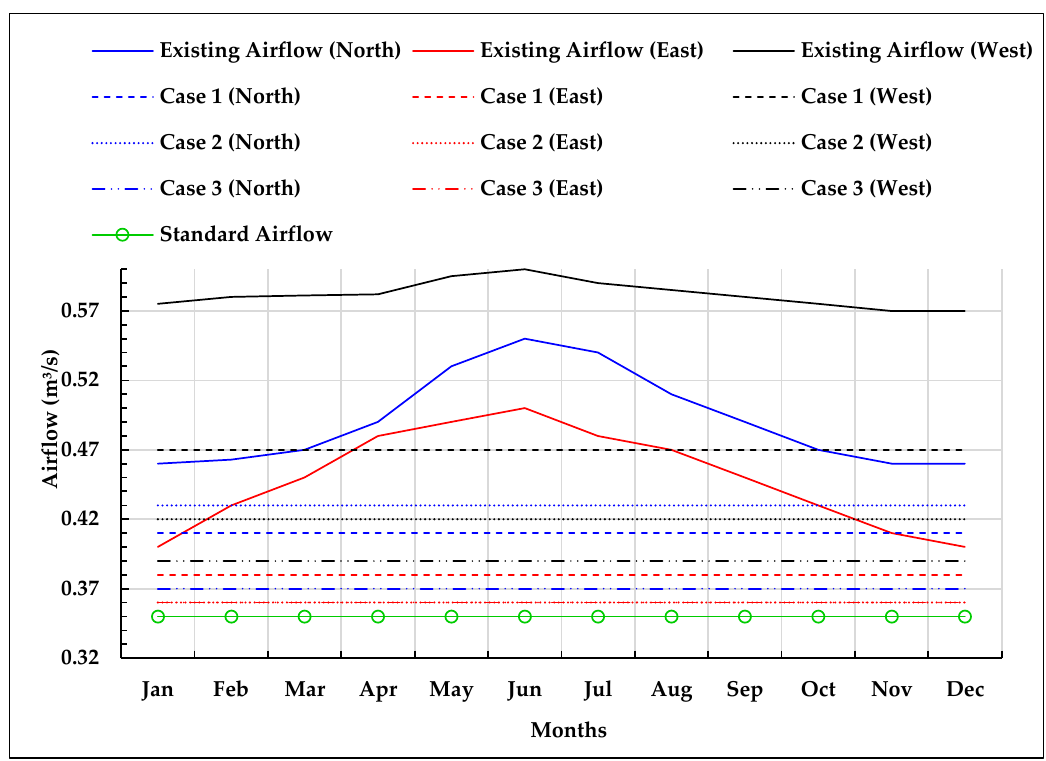
Figure 6. Airflow in the ACB with EAHEs 1 (west), 2 (north), and 3 (east) under cases 1, 2, and 3.